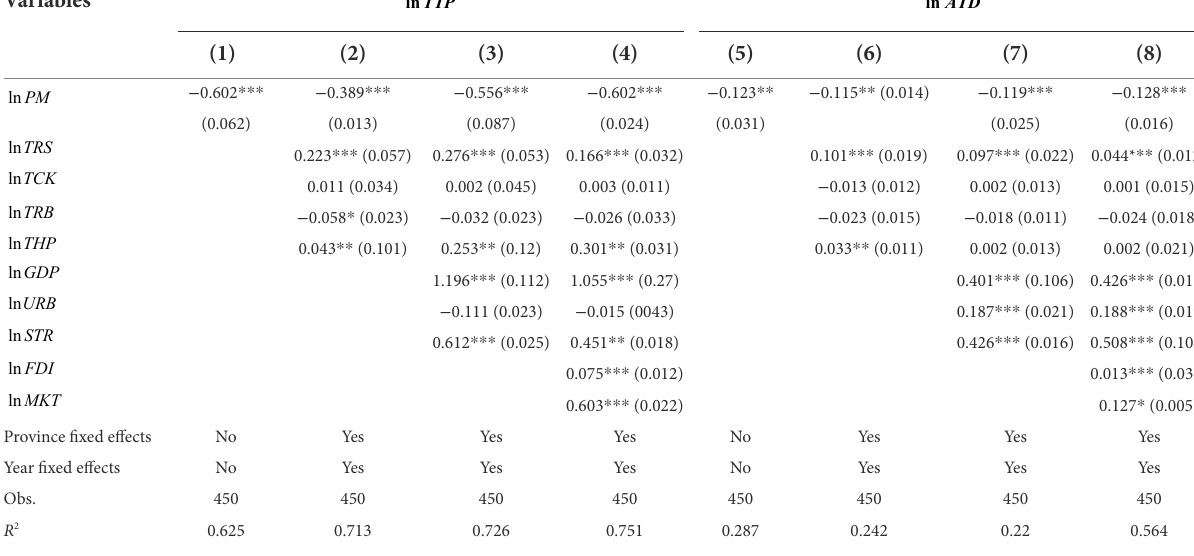
TABLE 1 Full sample estimation